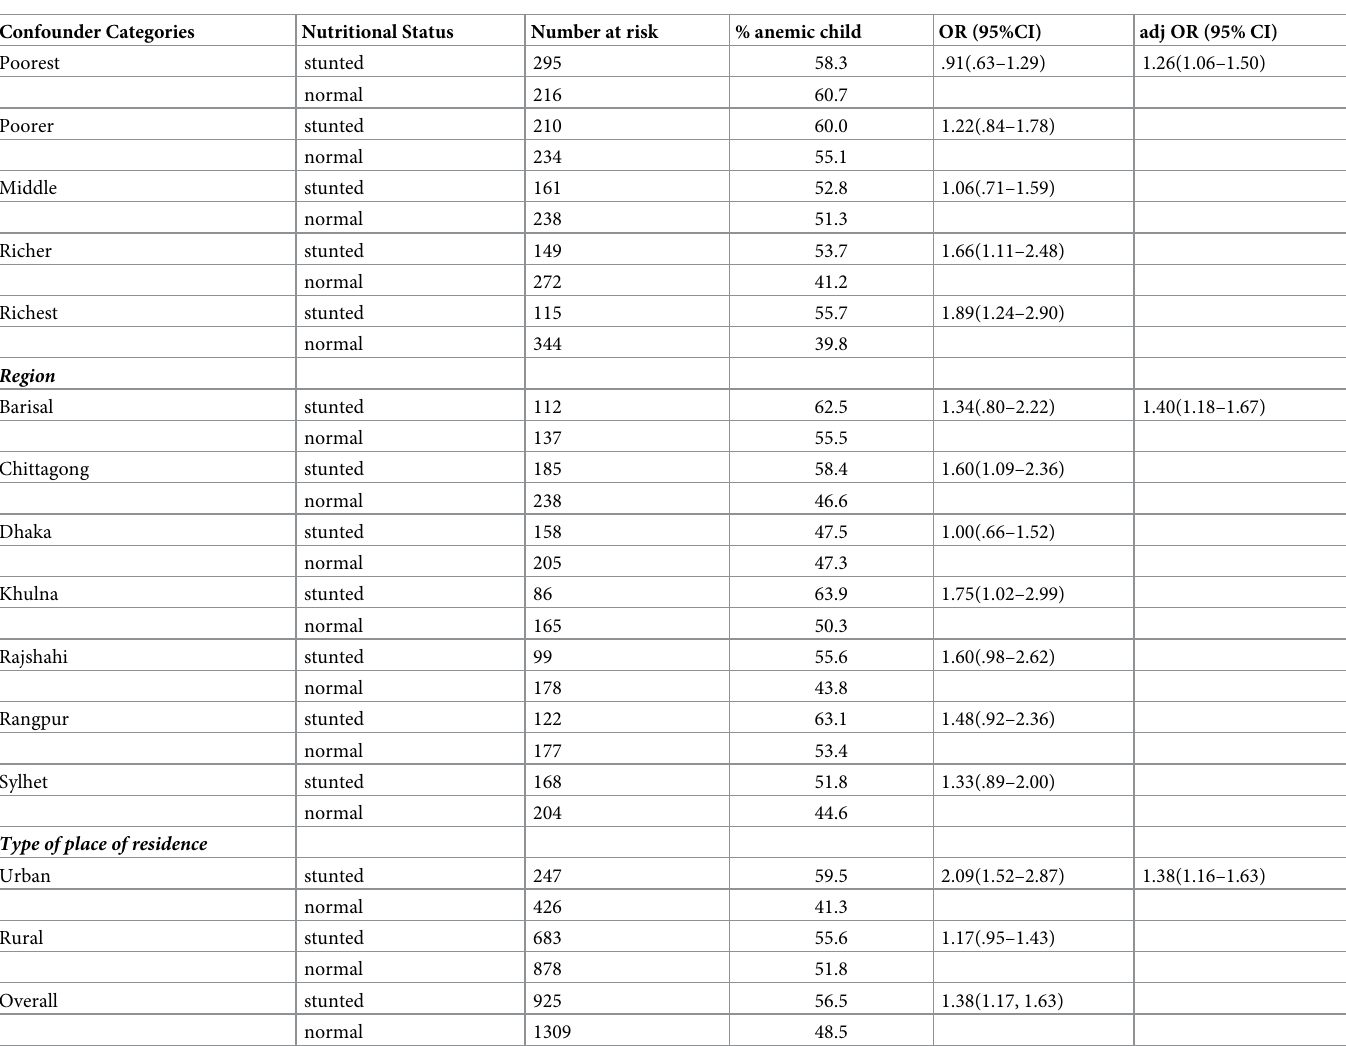
developing anemia among normal children but not in stunted children. (Fig 2: left). The effect of stunting also varies across the levels of maternal anemia and SES (Fig 2: right). The stunted children of anemic mothers are at greatest risk of developing anemia whereas the normal chil- dren of non-anemic mothers are at the lowest risk of developing anemia. The difference in risk between these groups increases slightly with increasing SES. Interestingly, non-stunted chil- dren of anemic mothers have elevated risk of developing anemia compared to non-stunted children of anemic mothers across all SES. Improvement in SES results in rapid decline in risk among normal children but not as much among stunted children. Thus, both maternal anemia and SES are strong effect modifiers of stunting. Similarly, in the final multivariable model for women anemia, BMI is found to be signifi- cantly associated with anemia status, with the estimated adjOR of 1.80 (95% CI: 1.10–3.48) (Table 6). The interaction plot for BMI, age and education suggests that the risk of maternal anemia increases with increasing age for women with no education or primary education